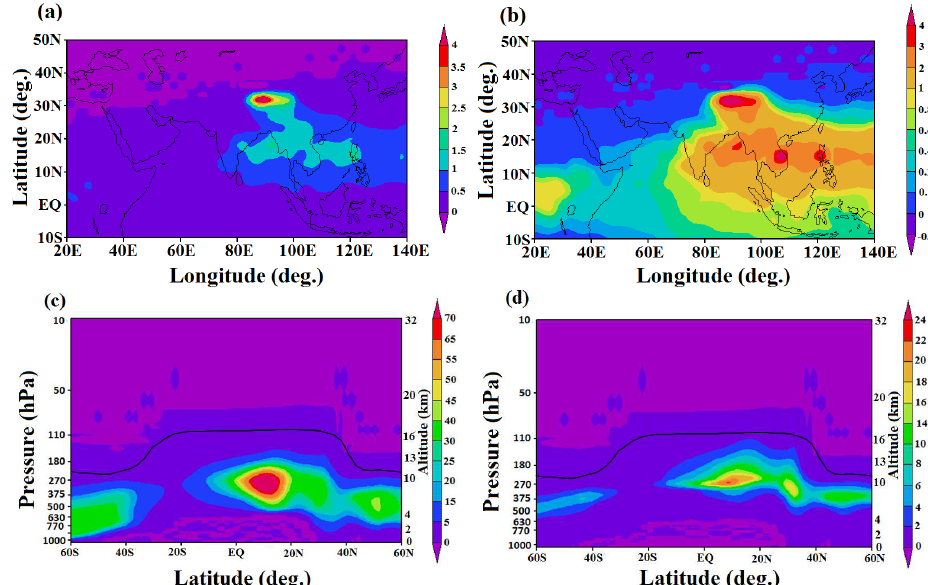
Fig. 8. (a) Horizontal structure as obtained from ECHAM5-HAMMOZ CTRL simulations (averaged for ASM) of (a) cloud ice water (decigramm − 2 ) at 110hPa, (b) ice crystal number concentration (1mg − 1 ) at 110hPa, (c) latitude–pressure cross section (averaged for June–September and 60–120 ◦ E) of cloud ice water (decigramm − 2 ) , and (d) latitude–pressure cross section (averaged for June–September and 60–120 ◦ E) of ice crystal number concentration (ICNC) (1mg − 1